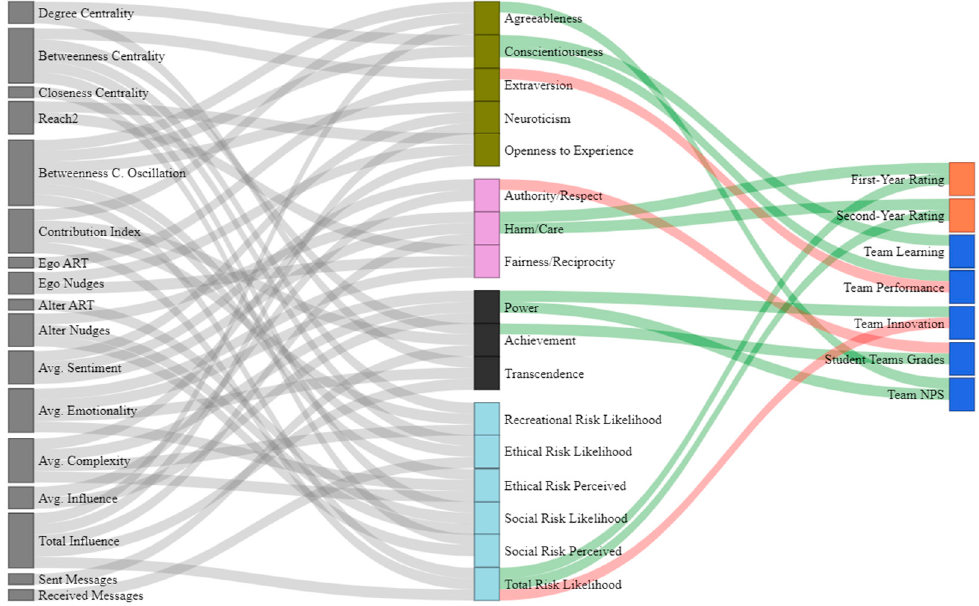
Figure 7. Summarized Prediction